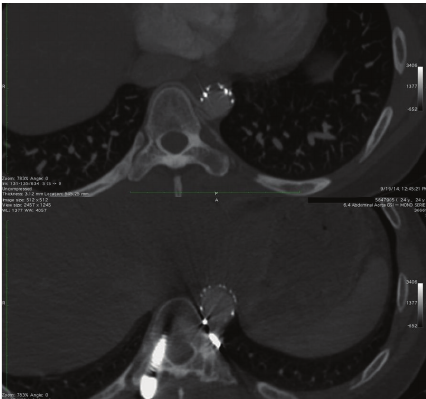
Figure 3: Two-year postoperative CT reveals the patency of the intercostal vessels and the restoration of the thoracic